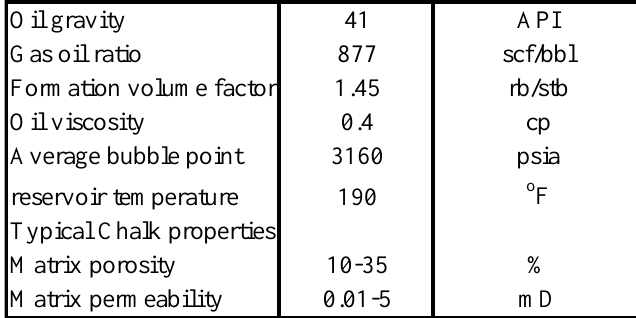
Table A.1 Reservoir data for Machar Field (SPE 36832, 56974).